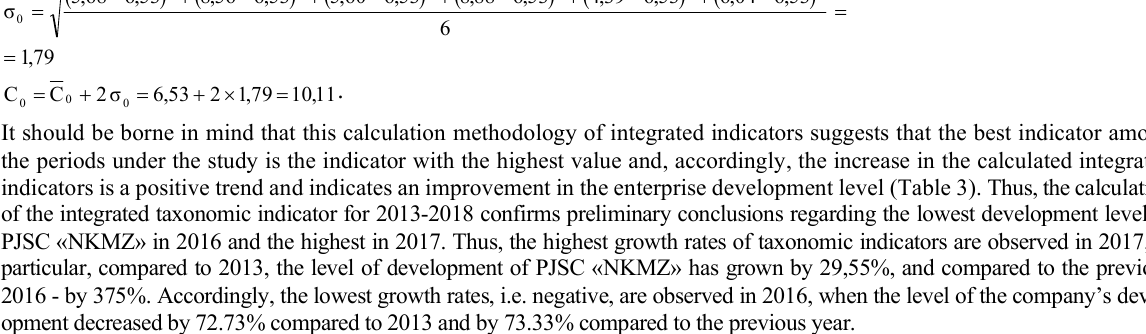
The development level of PJSC «NKMZ» in the conditions of ATO Years ITI